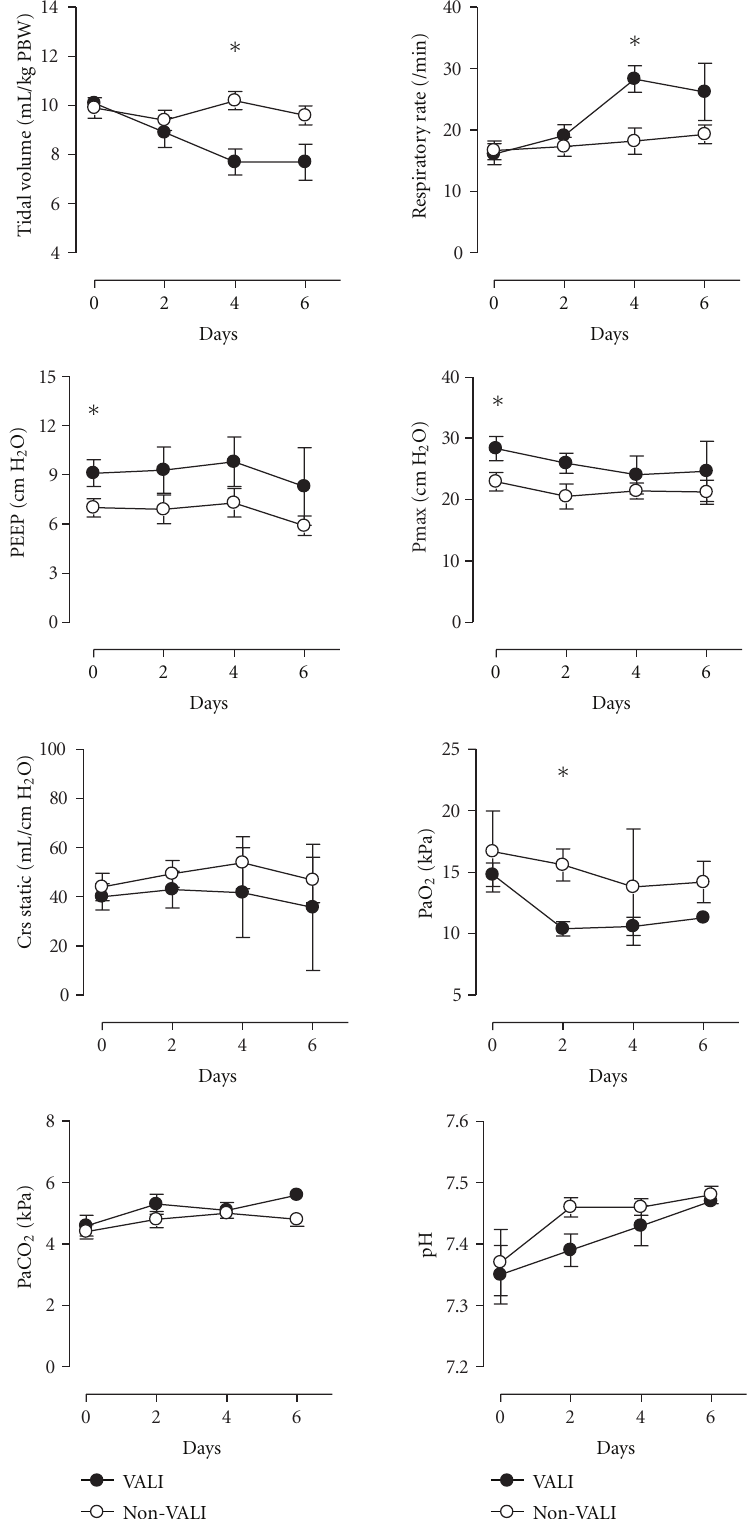
Figure 1: Ventilatory parameters. Tidal volumes per kilogram of predicted body weight (PBW), respiratory rate, positive end expiratory pressures (PEEP), maximum airway pressures ( P max ), compliance and blood gas analyses data in patients who developed VALI (closed symbols, n = 10), and patients who did not develop VALI (open symbols, n = 10). Data are mean ± SD. ∗ P < 0 .